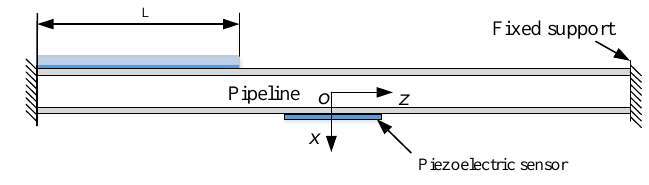
Figure 10. Axial length of ACLD on t he pipeline.